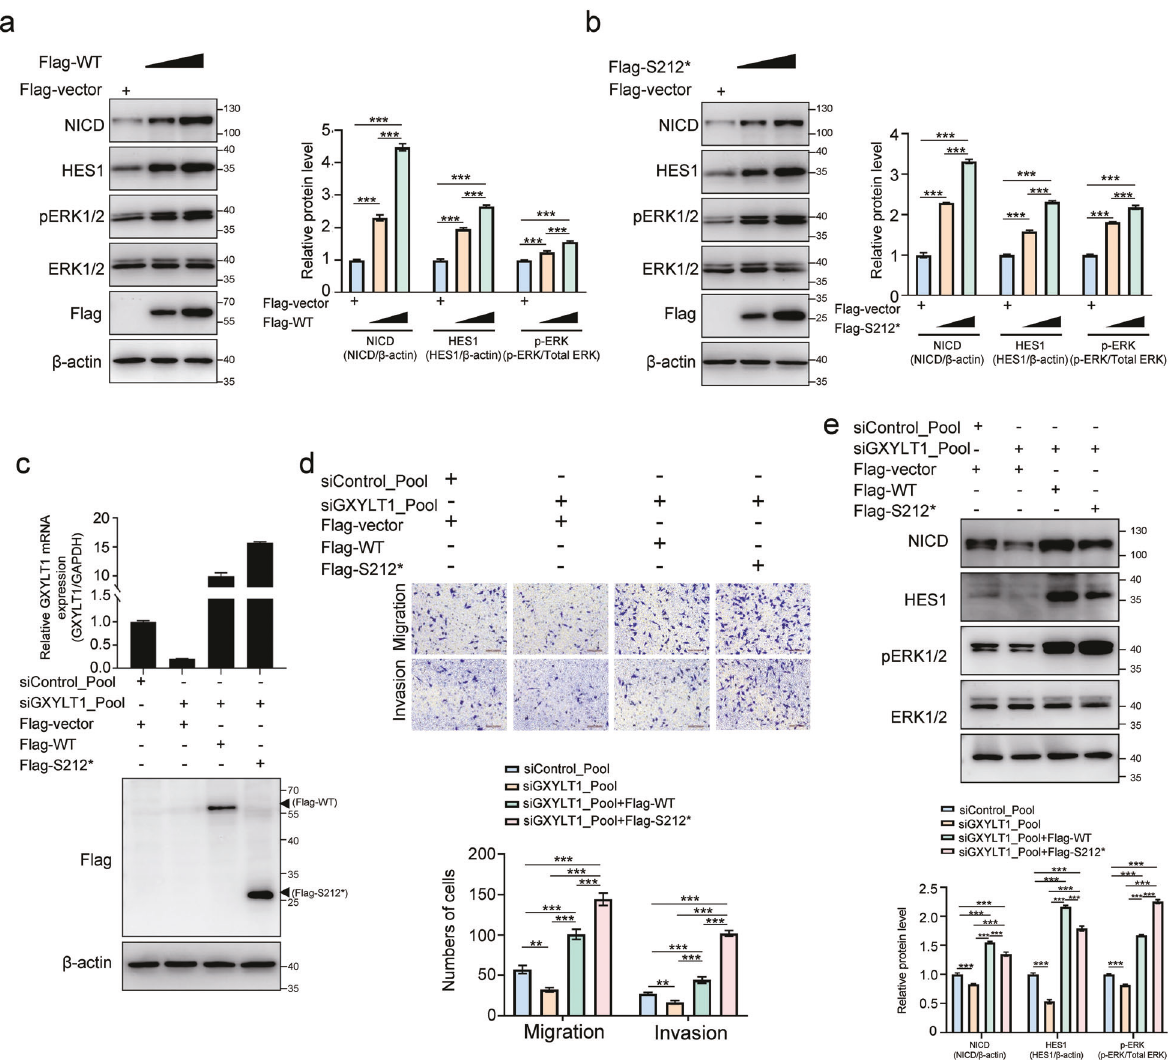
western blot after 48 h. Bar graphs show quanti fi cation of NICD, Hes1, and pERK1/2 levels. c RKO cells with indicated transfection were harvested for RT-PCR analysis and Western blot analysis to determine the expression of GXYLT1 and GXYLT1 S212* . d Transwell migration and invasion assays of RKO cells with indicated transfection. Graphs show quanti fi cation of migrated cells. e Western blot analysis of cell lysates with the indicated antibodies. RKO cells with indicated transfection were harvested for Western blot after 48 h. Bar graphs show quanti fi cation of NICD, Hes1, and pERK1/2 levels. Data are presented as the mean ± SD of at least three independent experiments. * p < 0.05, ** p < 0.01, *** p <